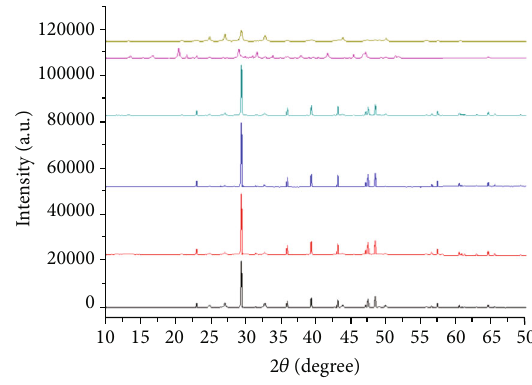
Figure 11: XRD test of cement samples.